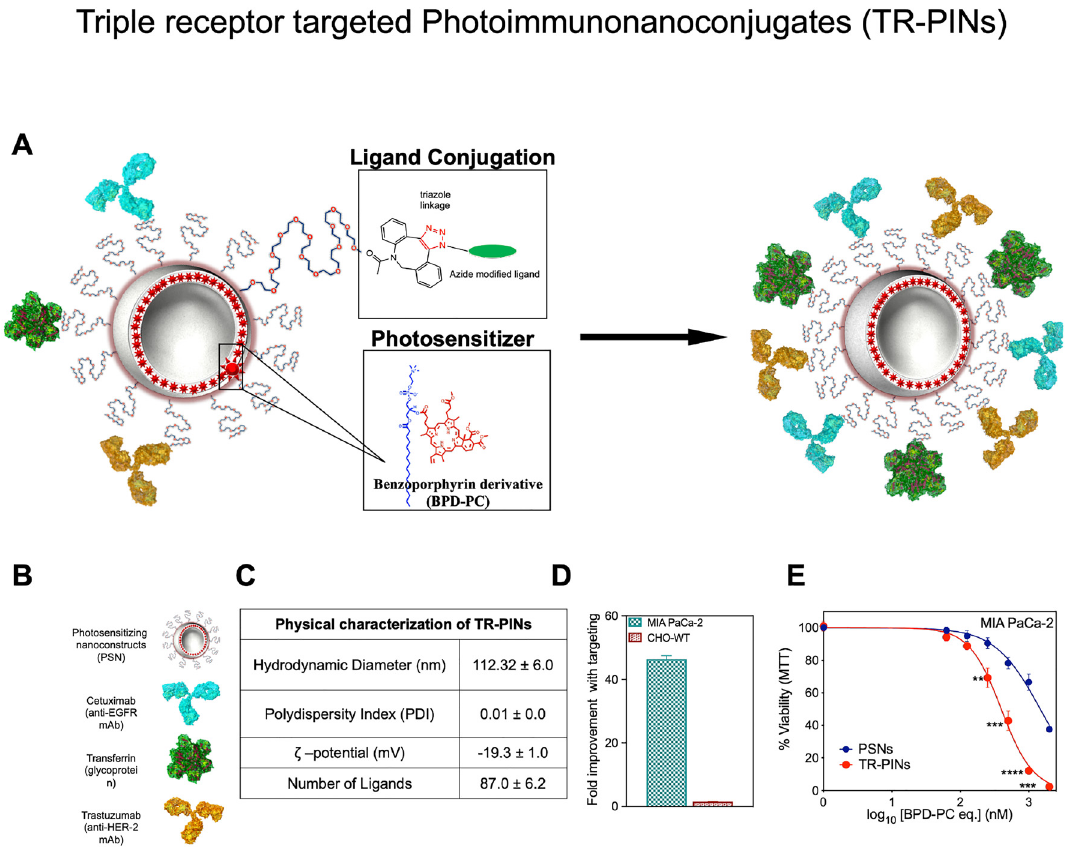
Figure 2: Schematic representation of the design of triple-receptor-targeted photoimmuno-nanoconjugates (TR-PINs). Designoftriple-receptor-targetedphotoimmuno-nanoconjugates(TR-PINs)(A)andtheligands(B)conjugatedviaacopper-freeclickchemistry approach. Physical characterization of the TR-PINs (C). TR-PINs exhibit a significant improvement in binding to MIA PaCa-2 cells (D). BPD-PC emission intensities measured via flow cytometry were used to analyze TR-PINs cellular binding as compared to the photosensitizing nanoconstructs (PSNs). Representative phototoxicity dose − response curves of the PSNs and the TR-PINs in MIA PaCa-2 monolayers (E). The NIRphotodynamicactivationregimenemployed690nmlightirradiationand20J/cm 2 at150mW/cm 2 (mean ± SEM; n =9 – 12fora − c;one-way ANOVA with a Tukey post-test; ∗∗∗∗ P ≤ 0.0001, ∗∗∗ P ≤ 0.001, ∗∗ P ≤